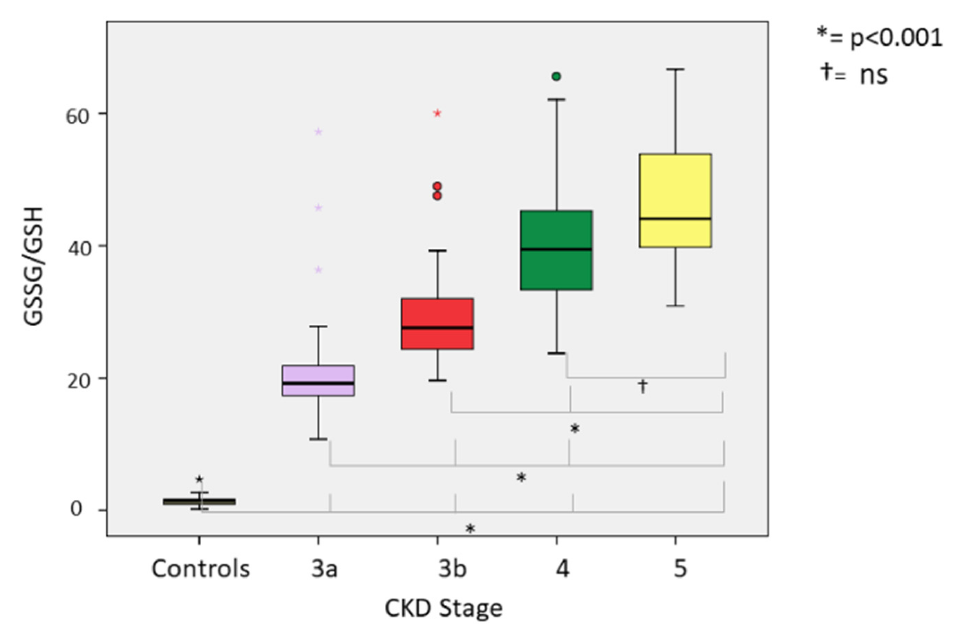
Figure 4. GSSG/GSH ratio in different stages of CKD.